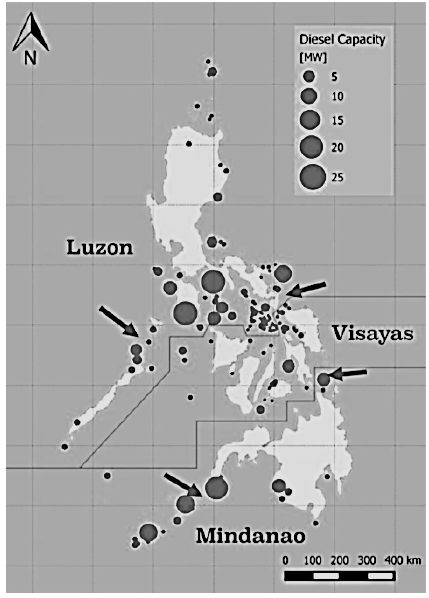
Figure 2. Potential locations replacing diesel generators in the Philippines.